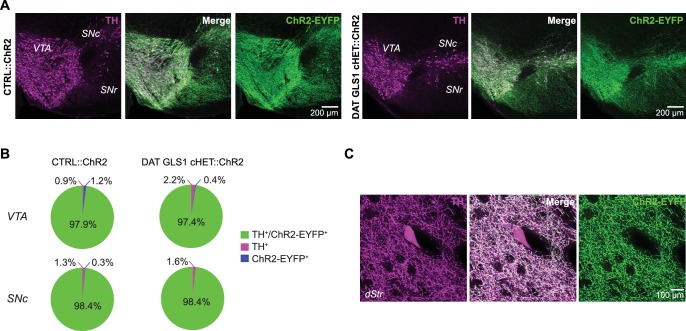
Comparison between CTRL::ChR2 and DAT GLS1 cHET::ChR2 mice showing selective ChR2 expression in DA neurons did not differ between genotypes.(A) ChR2-EYFP expression (green) in the ventral midbrain was restricted to TH+ cells (magenta), with similar colocalization (white) in both CTRL::ChR2 mice (left) and DAT GLS1 cHET::ChR2 mice (right). (B) Stereological counts of ChR2-EYFP and TH+ cells in the VTA and SNc of CTRL::ChR2 (n = 3) and DAT GLS1 cHET::ChR2 mice (n = 3). Values are presented as percent of the total number of cells counted in each region, for each genotype (VTA, CTRL::ChR2 = 5097 ± 817 cells and DAT GLS1 cHET::ChR2 = 3891 ± 628 cells; SNc, CTRL::ChR2 = 4782 ± 889 cells and DAT GLS1 cHET::ChR2 = 3345 ± 453 cells; Kruskal-Wallis test in each region showed no genotype effect). The percentage of TH+/ChR2-EYFP+ cells did not differ genotypically, in the VTA or SNc (Kruskal-Wallis test). (C) TH+ interneurons (magenta) in the dorsal striatum (dStr) did not express ChR2-EYFP (green).